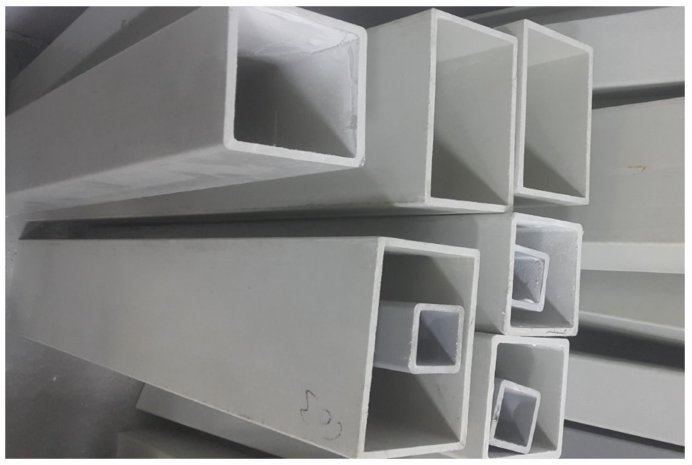
Figure 1. Conventional box pultruded